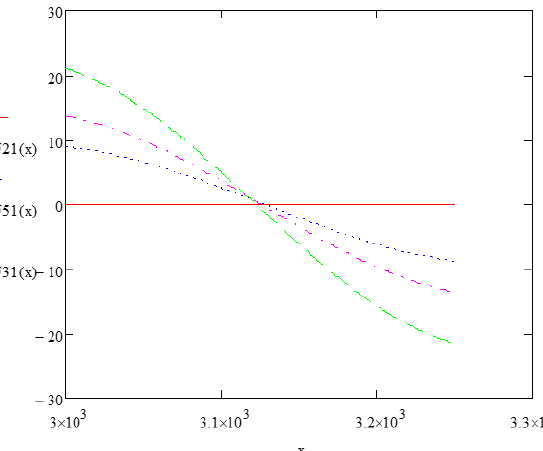
Figure 7. The difference signal of the change in the conductivity of the SmS-based-sensor over time during its heating at three different concentrations of solvent vapors in atmospheric air.